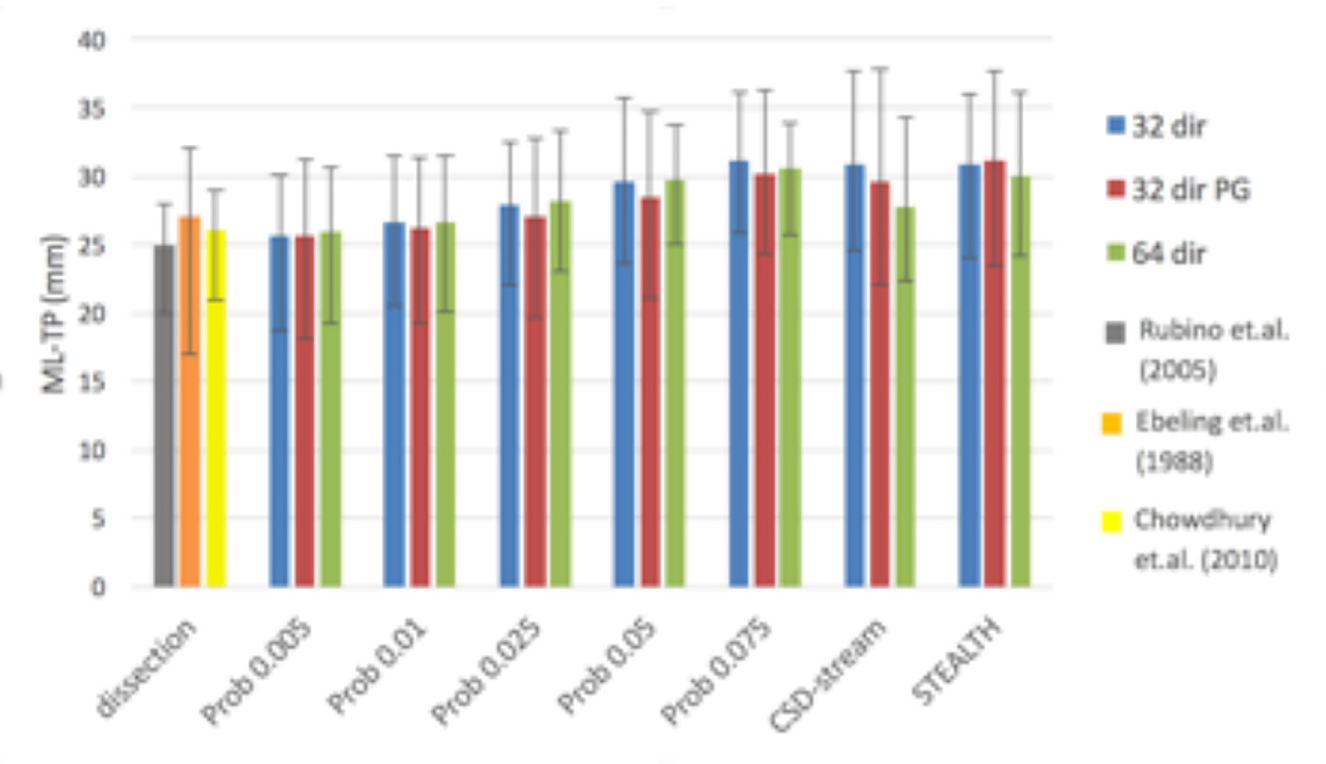
Fig 6. Average ML-TP distances for the optic radiation across 10 volunteer subjects compared against the three largest reported dissections studies. Error bars depict the ML-TP range.